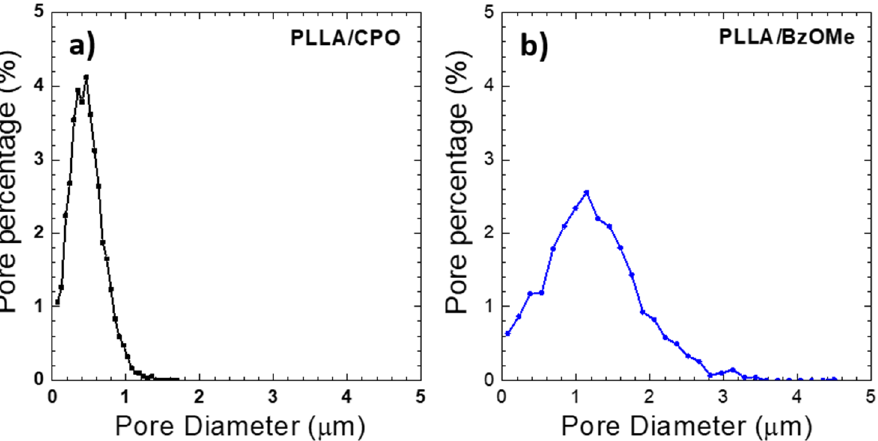
Figure 4. SPIP™ image analysis of SEM micrographs in Figure 3c,d: percentage of pores (assumed spherical) as a function of diameter: ( a ) PLLA/CPO aerogel and ( b ) PLLA/BzOMe aerogel.